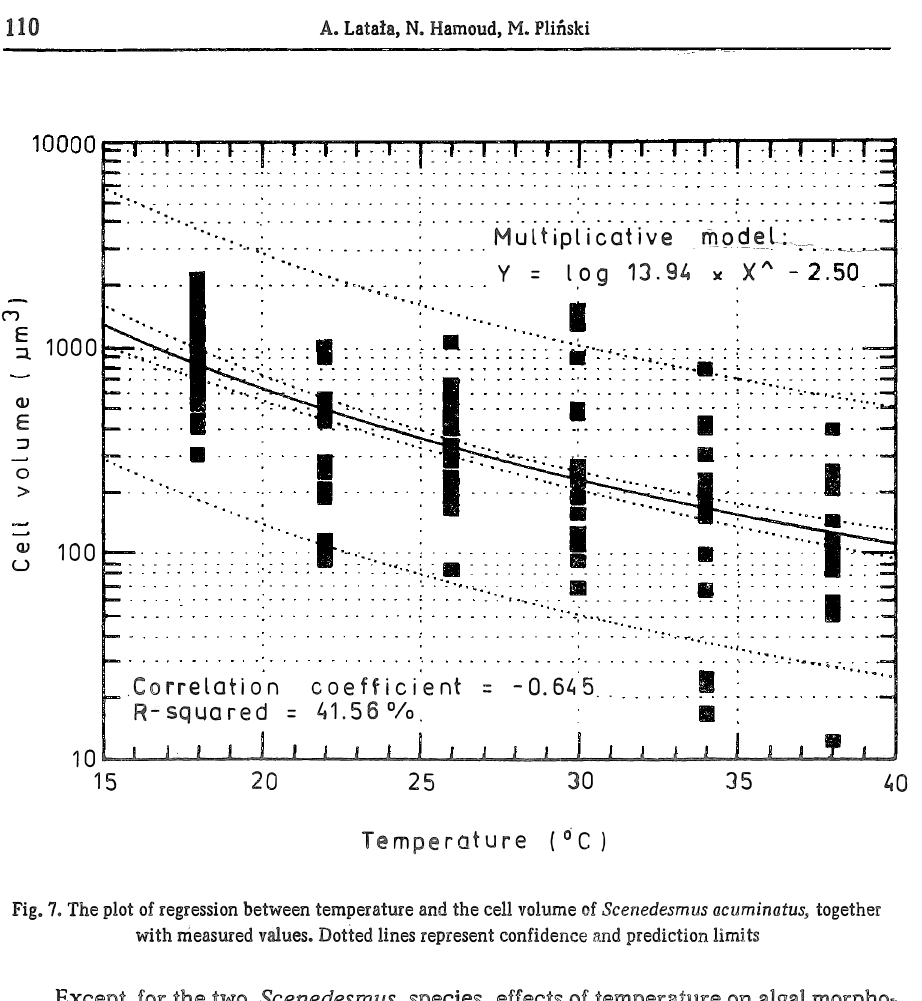
Fig, 7. The plot of regression between temperature and the cell volume of Scenedesmus acuminatus, together with measured values. Dotted lines represent confidence B.nd prediction limits